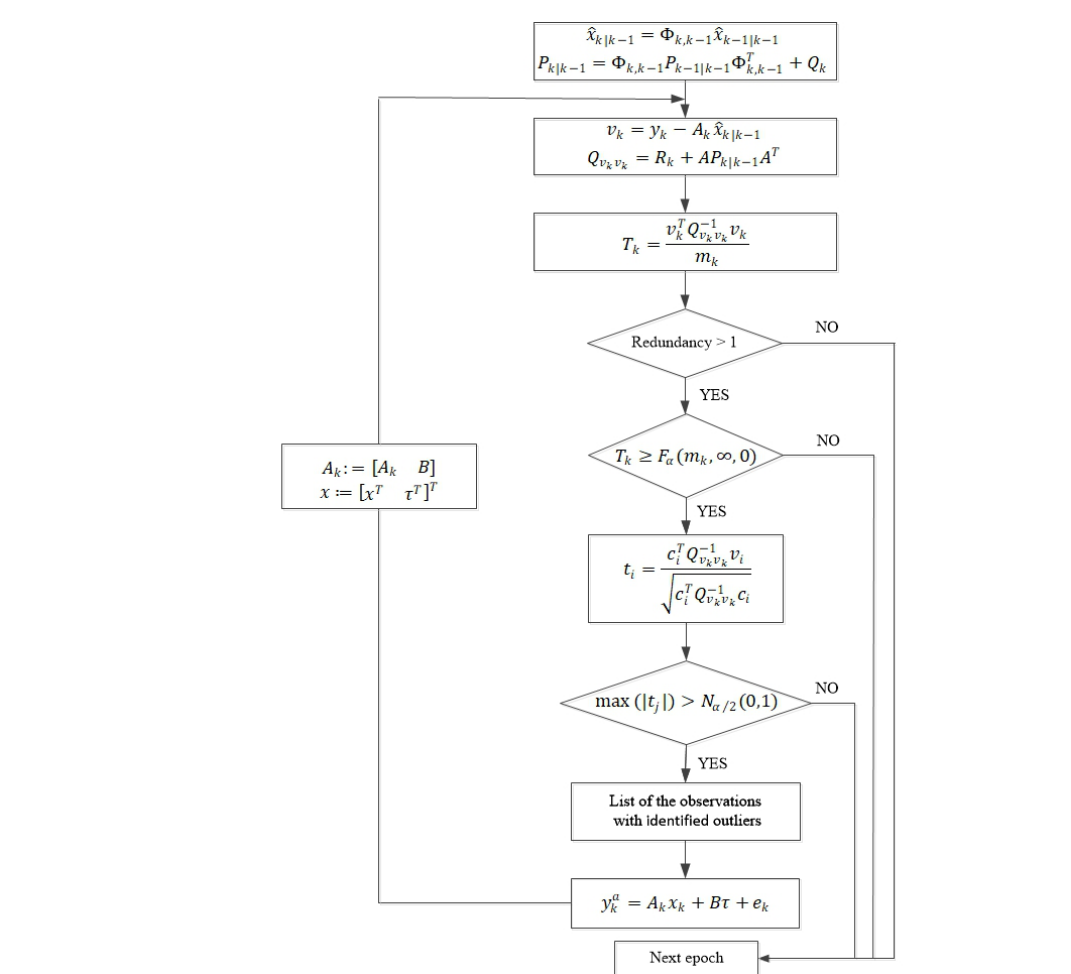
Figure 1. Procedure of detection, identification and